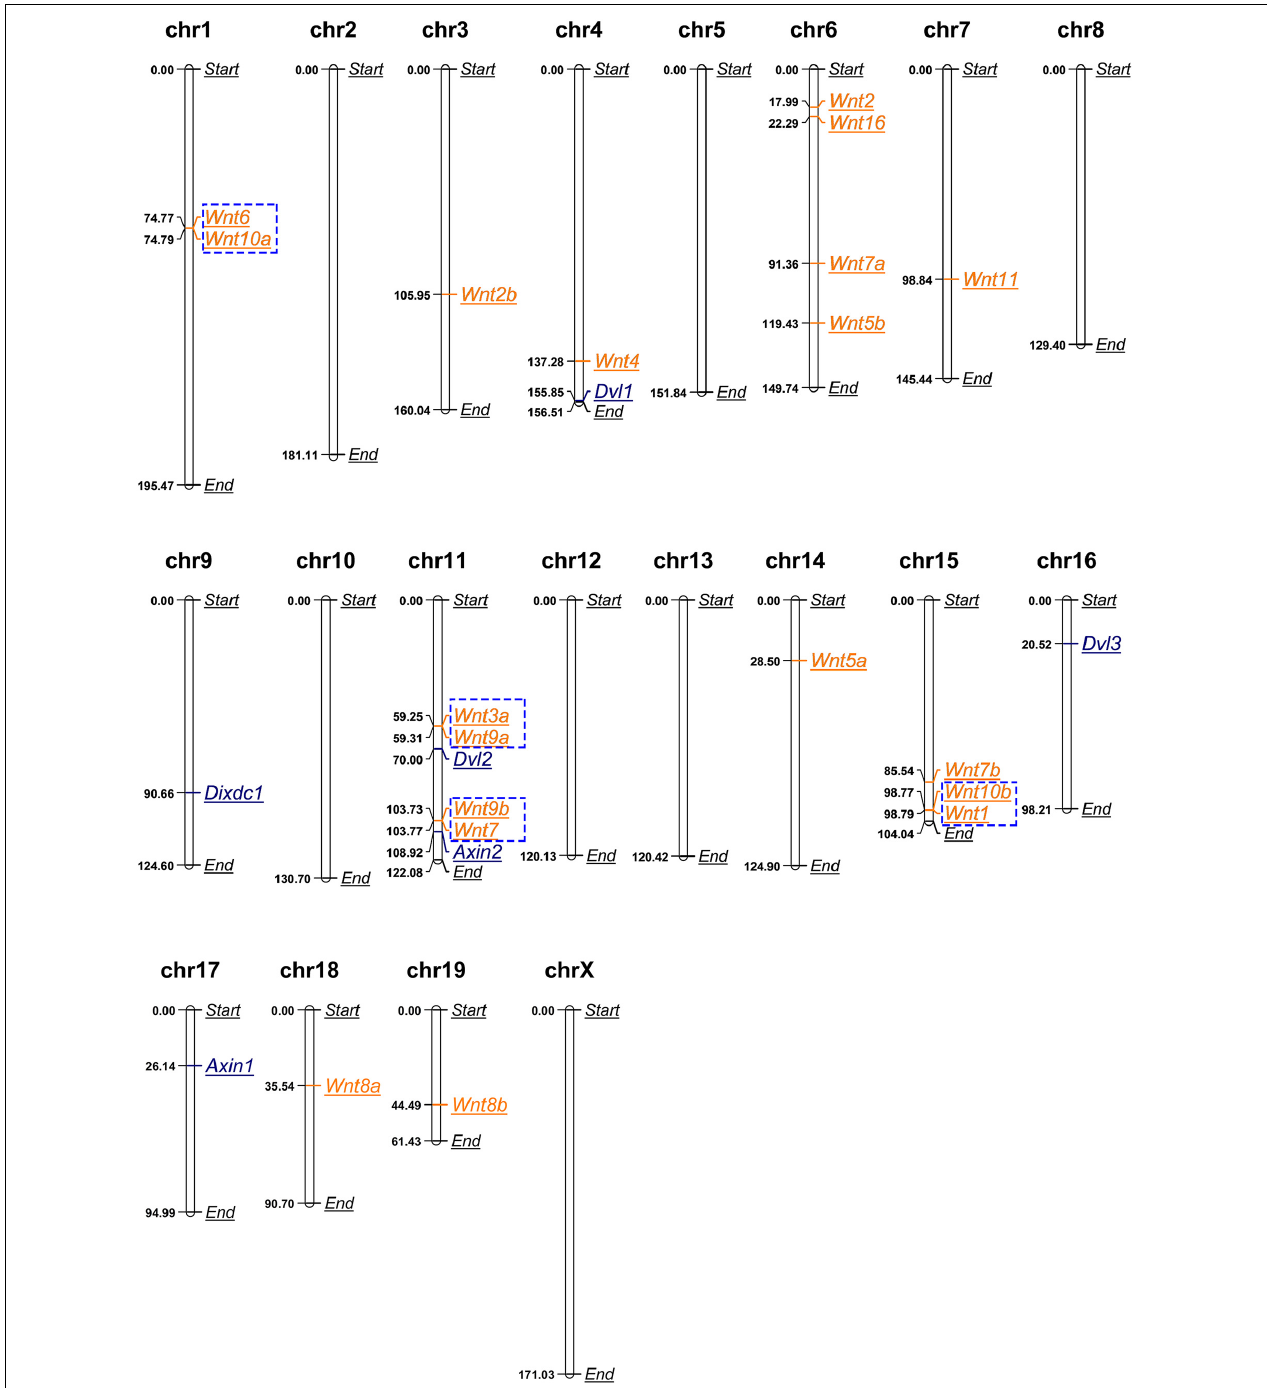
FIGURE 2 | Mouse Wnt genes locally accumulate in certain chromosomes. Chromosomal distributions of mouse Wnt and DIX genes. Genes in blue boxes are tandem duplication genes. The length unit for all chromosomes shown here is megabase (Mb).